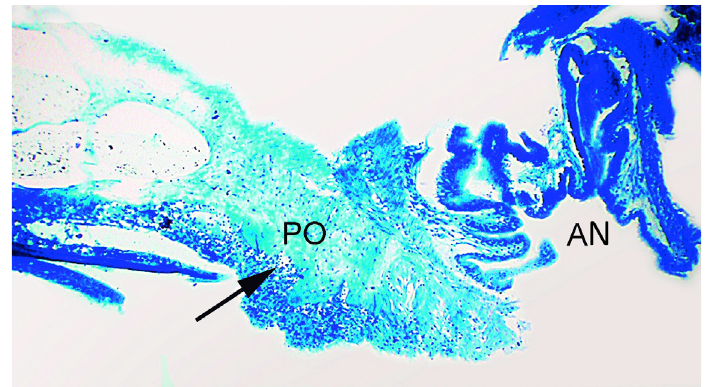
FIGURE 2 | Histological section of the adult male pre anal organ, in sagittal view, showing its acidophilic granules (26.97 mm SL; aquarium specimen). AN=anus; PO= pre anal organ; arrow = acidophilic